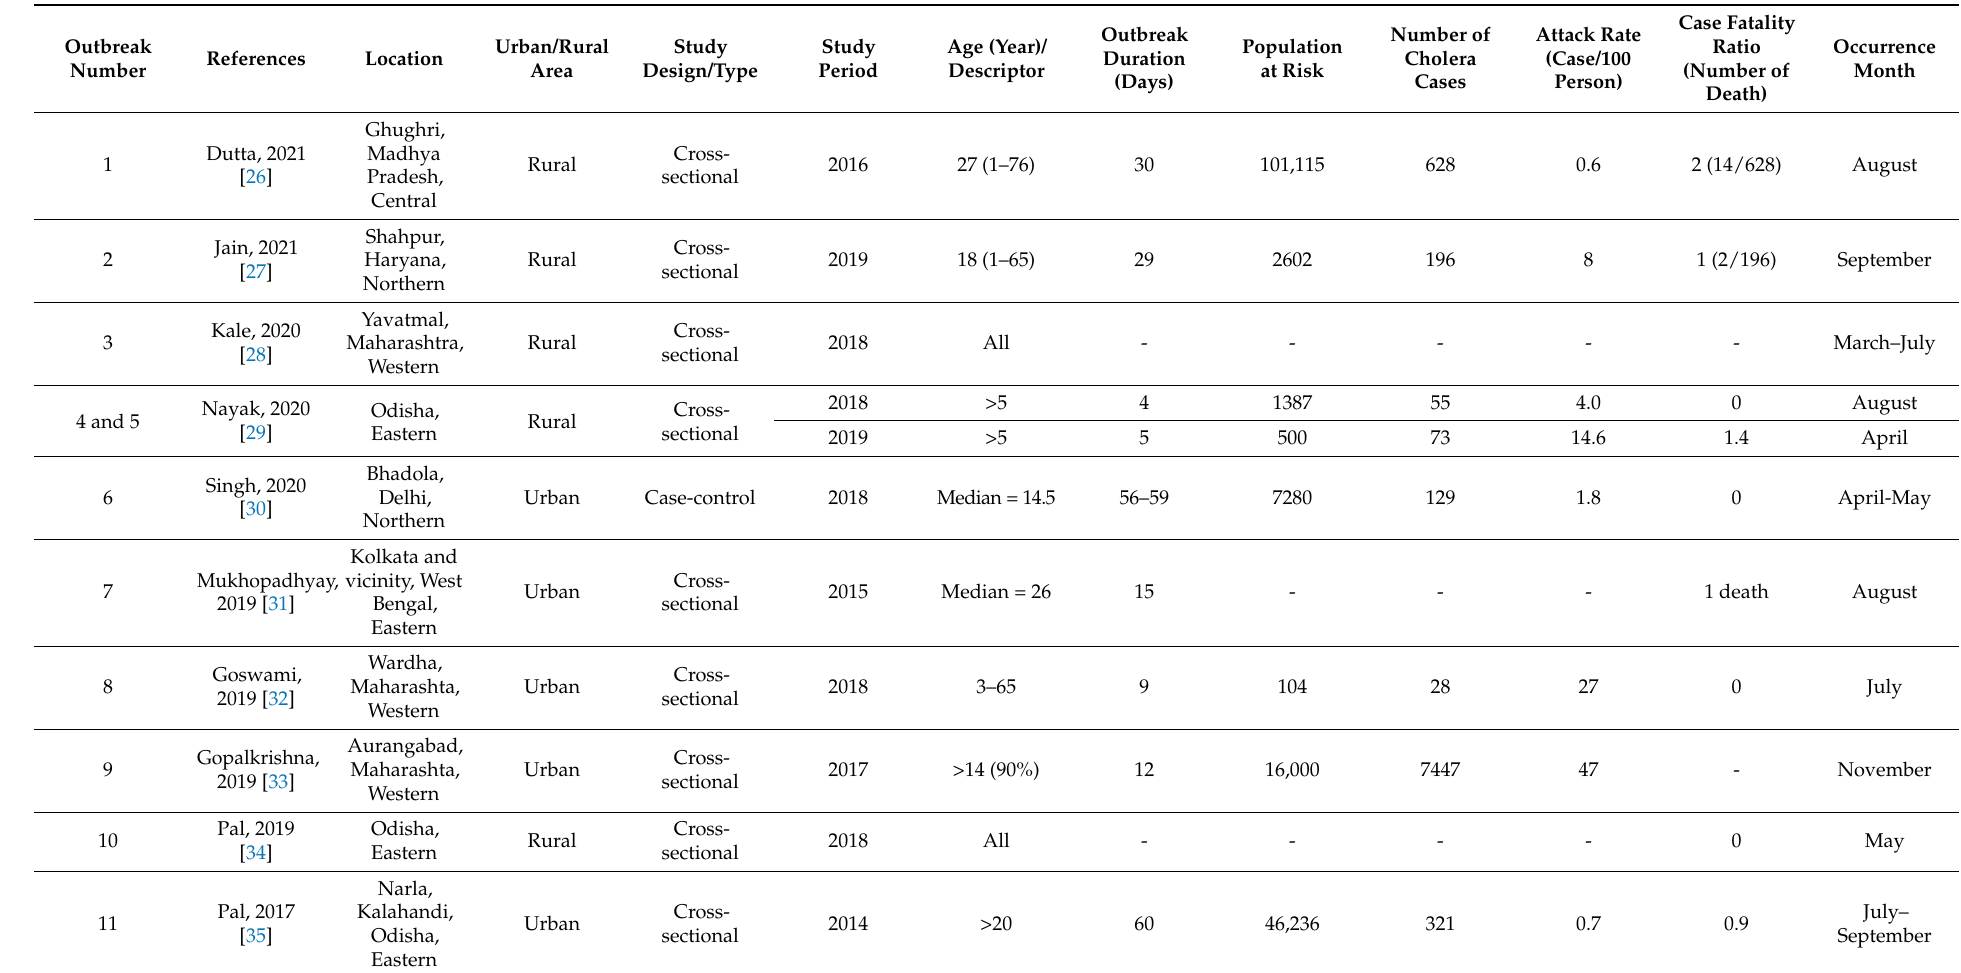
Table A1. Characteristics of included